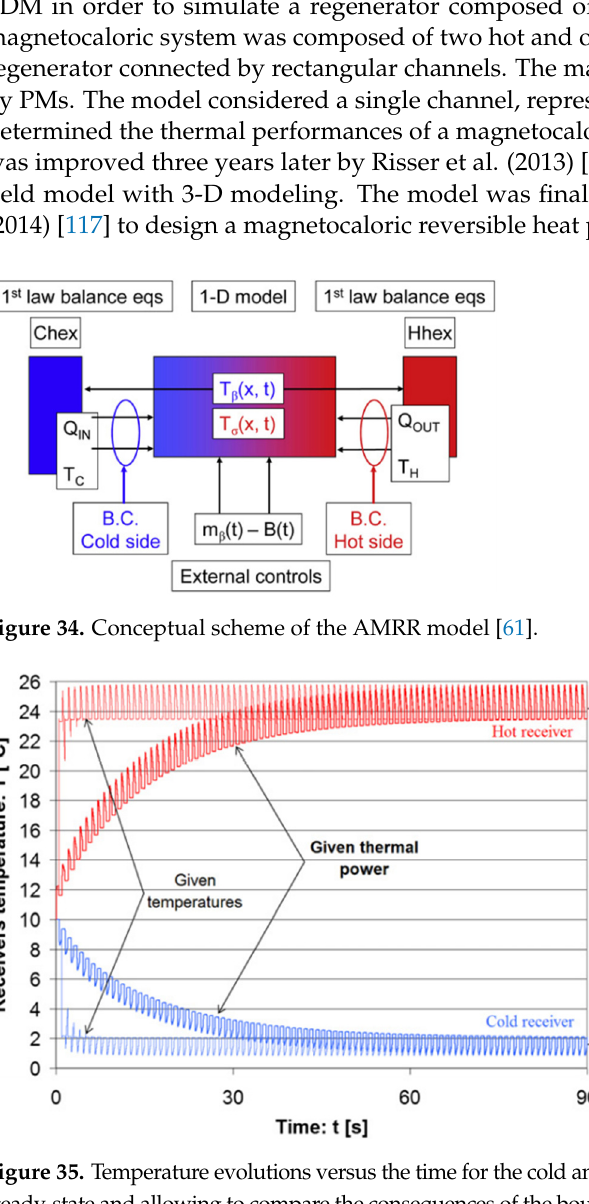
Figure 35. Temperature evolutions versus the time for the cold and hot receiver until reaching the thermal steady-state and allowing to compare the consequences of the boundary conditions on this evolution [117].